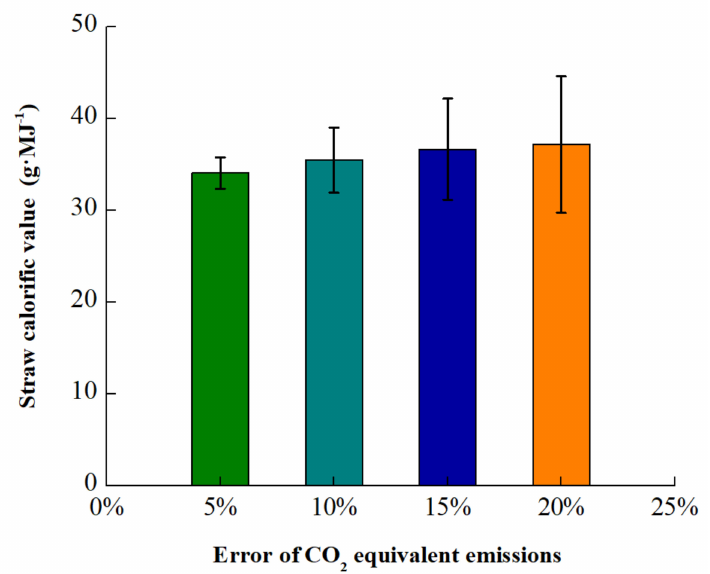
Figure 8. Error analysis for CO 2 equivalent emissions from the non-phase-transition drying pyrolysis and mass conversion technology based on fluctuations in straw calorific